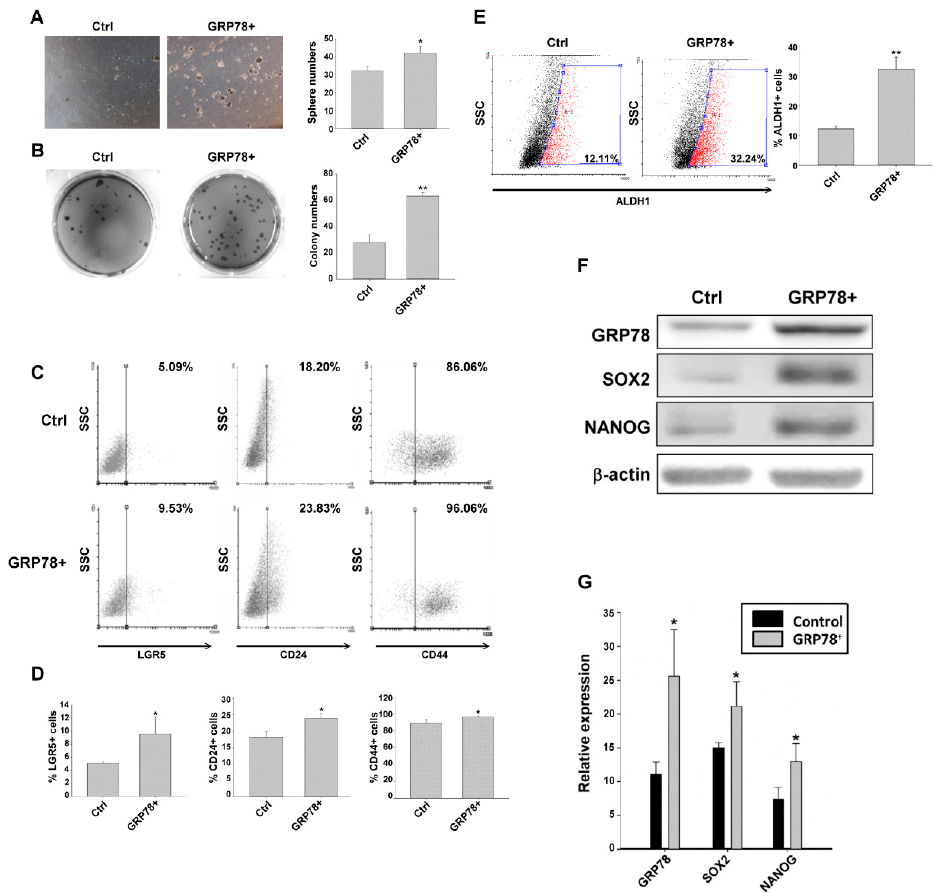
Figure 3. Glucose-regulated protein 78 (GRP78) promoted stemness in MKN45 cells. ( A ) Repre- sentative pictures showing spheroid body-forming and ( B ) colony-forming MKN45/ctrl and MKN45/GRP78 + cells. ( C ) Stemness-related surface makers (LGR5, CD24, and CD44) were analyzed through flow cytometry in MKN45/ctrl and MKN45/GRP78 + cells. ( D ) Quantification of the expres- sion of surface makers (LGR5, CD24, and CD44). ( E ) Aldehyde dehydrogenase 1-positive cells were analyzed through flow cytometry among MKN45/ctrl and MKN45/GRP78 + cells. ( F ) Protein expres- sion of stemness-related transcription factors (SOX2 and Nanog) and GRP78 in MKN45/ctrl and MKN45/GRP78 + cells. ( G ) Quantification of SOX2, Nanog, and GRP78 expression in MKN45/ctrl and MKN45/GRP78 + cells. Data are expressed as the mean ± standard error of mean; n ≥ 3 independ- ent experiments, two-tailed Student’s t test: * p < 0.05, ** p < 0.01. 3.4. ISL Inhibited GRP78 Expression and Suppressed Stem Cell–Like Characteristics in Human Gastric Cancer Cells ISL (Figure 4A) is a natural flavonoid. To evaluate whether ISL suppresses gastric cancer stem cell–like characteristics through GRP78 inhibition, the MKN45 cells were treated with ISL (15 or 25 μ g/mL) for 72 h. The results revealed that ISL inhibited GRP78 expression in the MKN45 cells in a dose–dependent manner (Figure 4B,C). CREB3L is a member of the UPR that acts on cyclic adenosine monophosphate (AMP) to promote the expression of target genes including GRP78 [21]. ISL inhibited CREB3L in a dose–depend- ent manner (Figure 4D,E). Moreover, ISL not only suppressed the formation of colonies